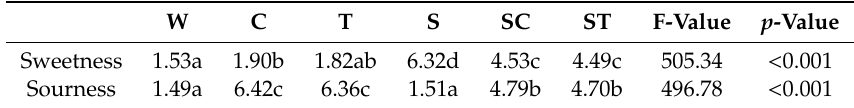
Table 3. Means of sweetness and sourness ratings for all samples, as well as F- and p -values for Analysis of Variance model. Samples are Water (W), Citric acid (C), Tartaric acid (T), Sucrose (S), Sucrose and Citric acid (SC), and Sucrose and Tartaric acid (ST). Letters are to be read row-wise, and they indicate significant di ff erences between samples based on Honest Significant Di ff erences (HSD).